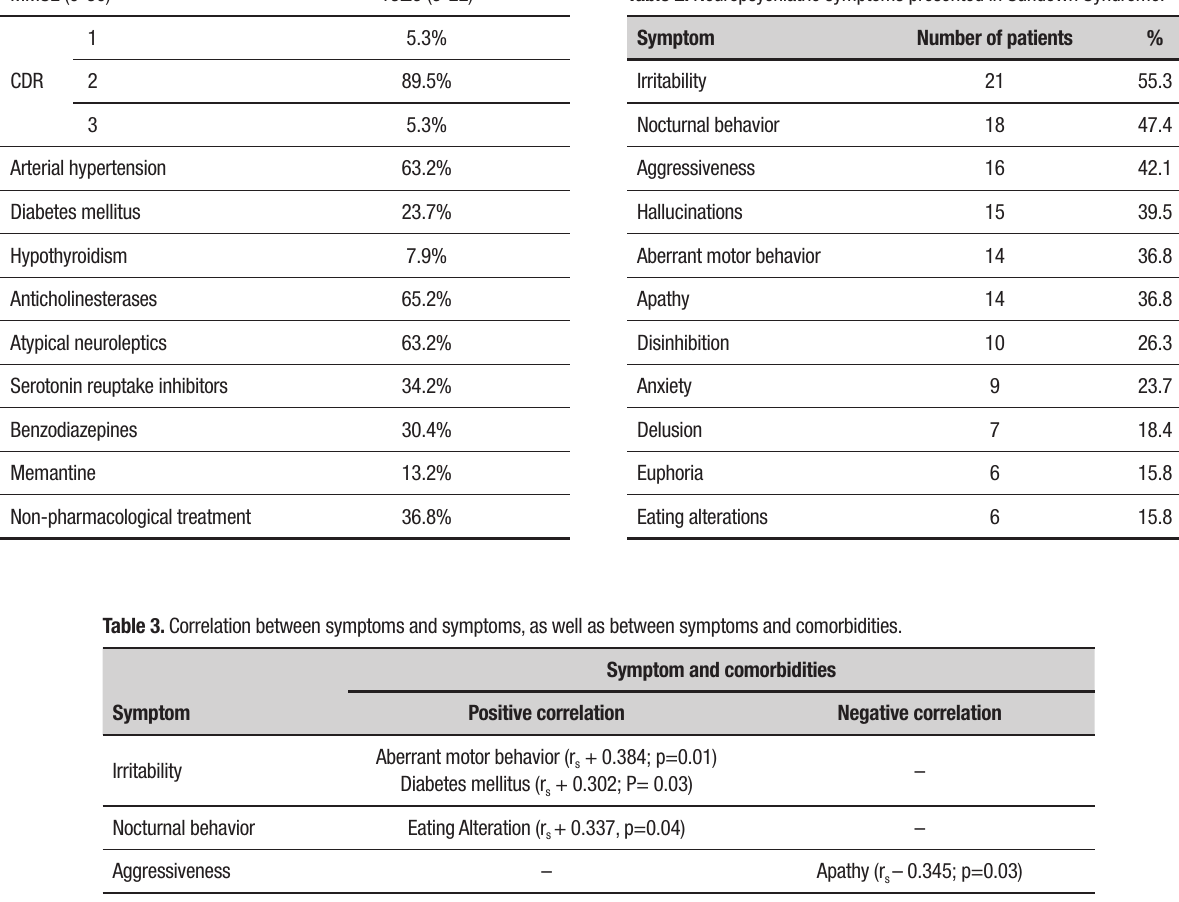
Table 2. Neuropsychiatric symptoms presented in Sundown Syndrome.